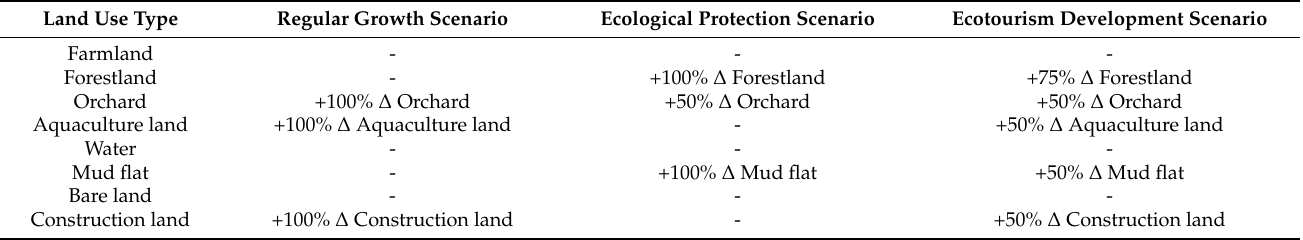
Table 3. Parameter setting for three